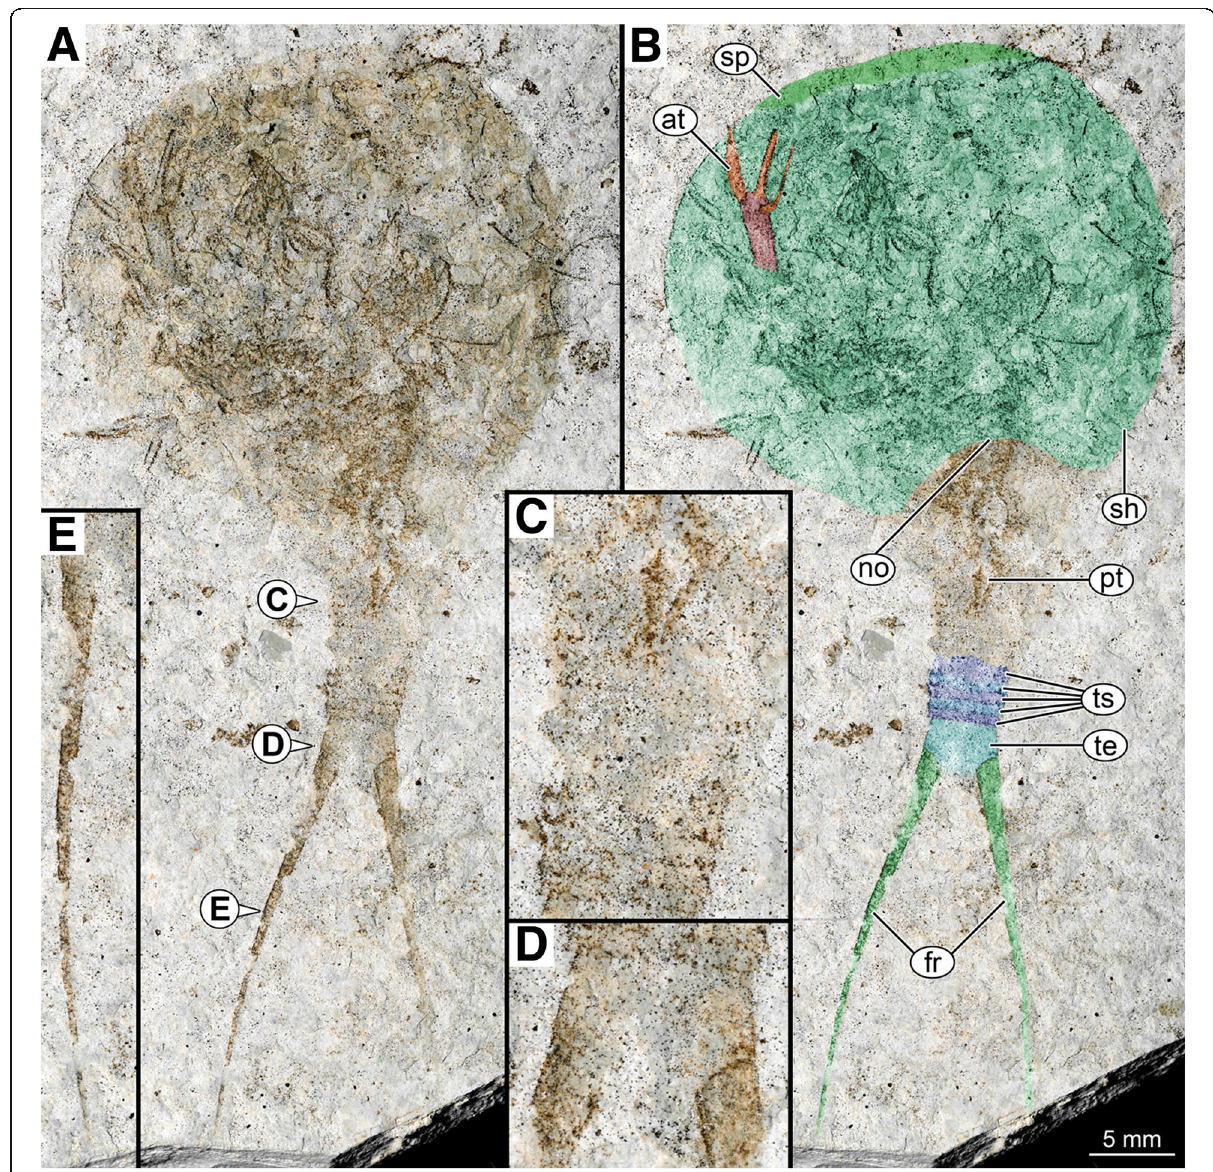
Fig.1 Morphology of Notostraca oleseni (SMNS 70488) from the Yixian Formation of north-eastern China (Lower Cretaceous, 125 – 121 million years). a Notostraca oleseni overview; b as A but with labeled structures and color markings; c Detail of trunk segments; d Detail of telson; e Detail of furcal rami; at, anterior thoracopod; fr, furcal rami; no, notch; pt, posterior thoracopods; sh, shield; sp, subfrontal plate; te, telson; ts,